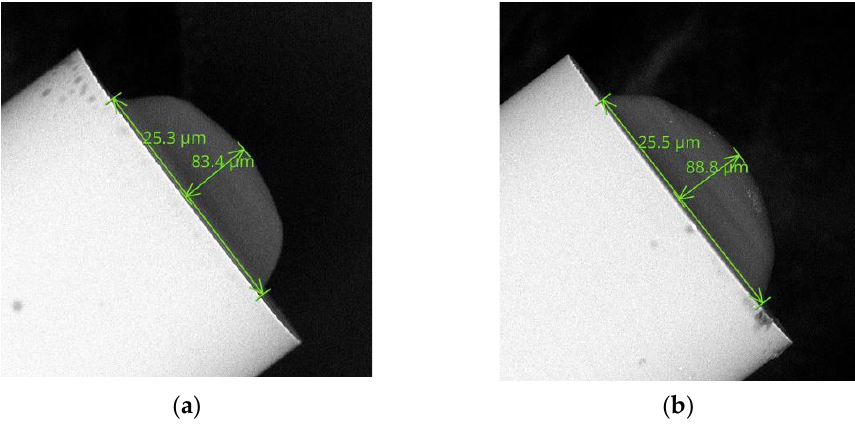
Figure 6. SEM images of UV microtips with the following base diameters and heights: ( a ) 83.4 μm, 25.3 μm; ( b ) 88.8 μm, 25.5 μm.